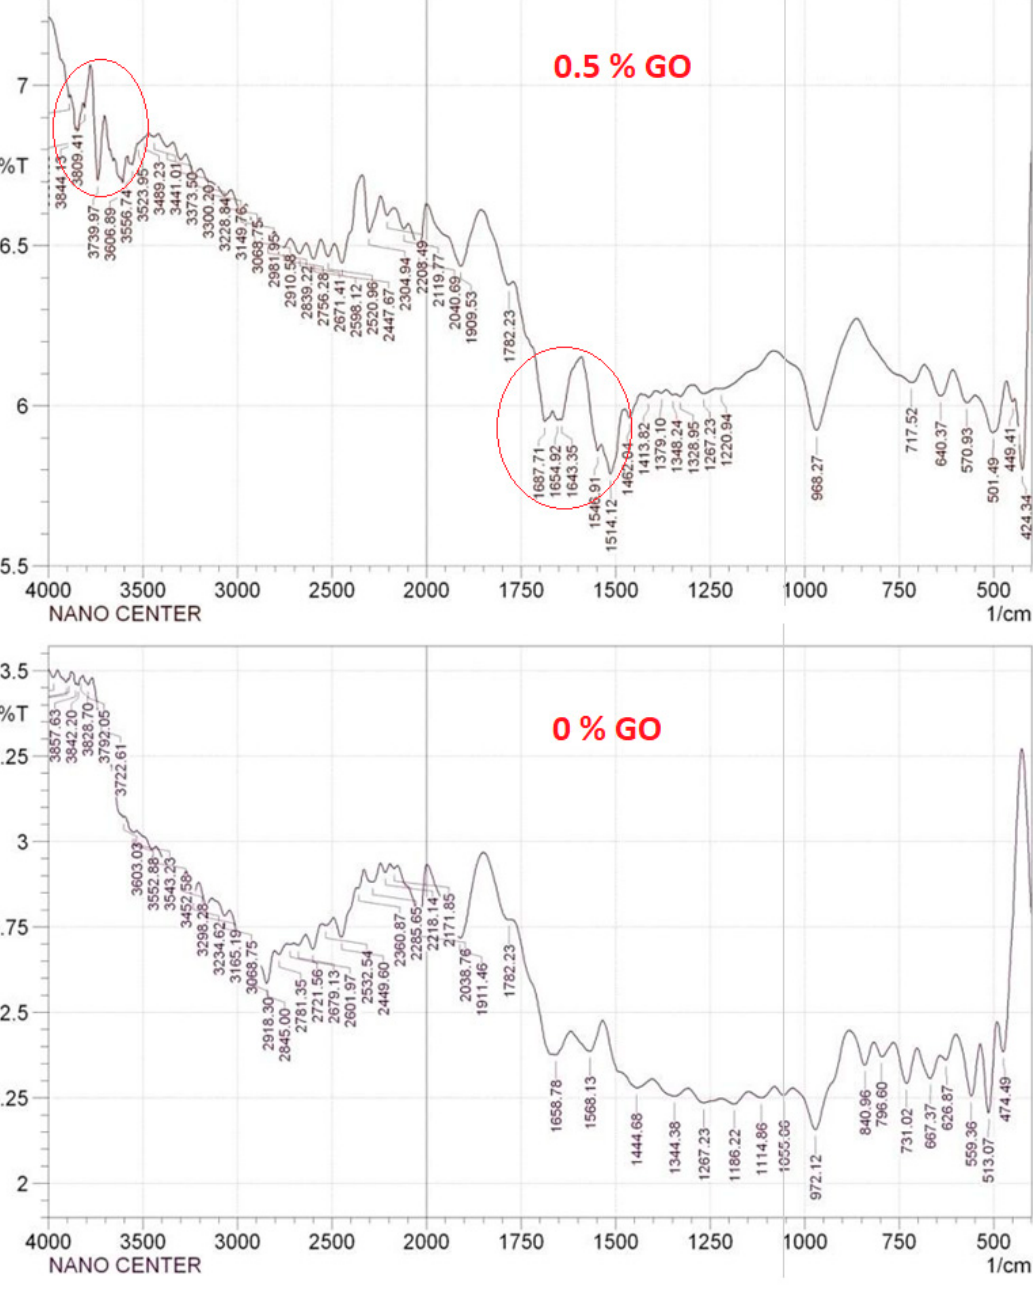
Figure 2. Fourier transform infrared ‐ attenuated total reflection (FTIR ‐ ATR) spectrum of the prepared